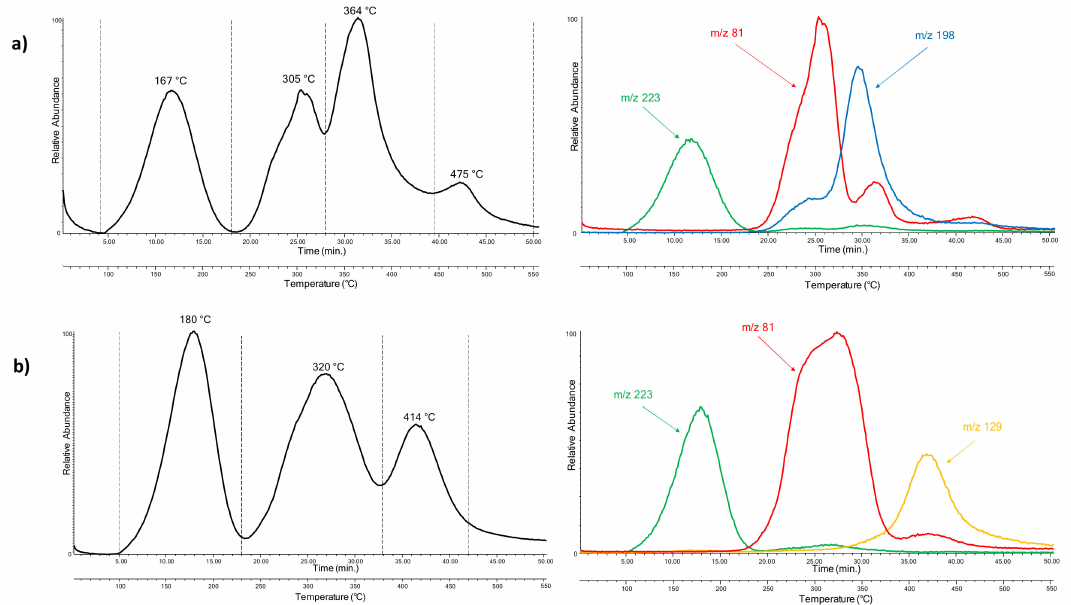
Figure 8. The EGA-MS curves and extracted ion thermograms obtained for samples from Gaetano Pesce chairs: ( a ) Nobody’s Perfect 1 ( m / z 223, 198, 81) and ( b ) Nobody’s perfect 3 ( m / z 223, 129,